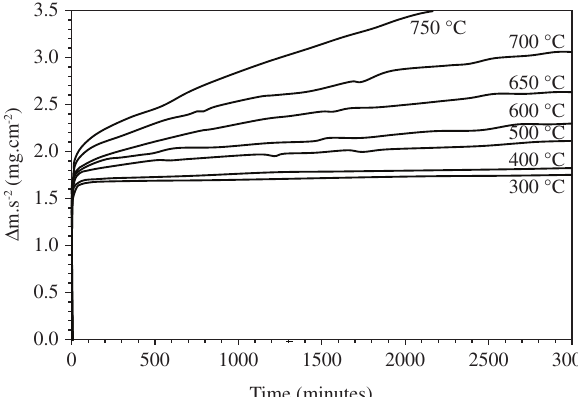
Figure 1. Isothermal oxidation kinetics of titanium in dynamic air atmos-